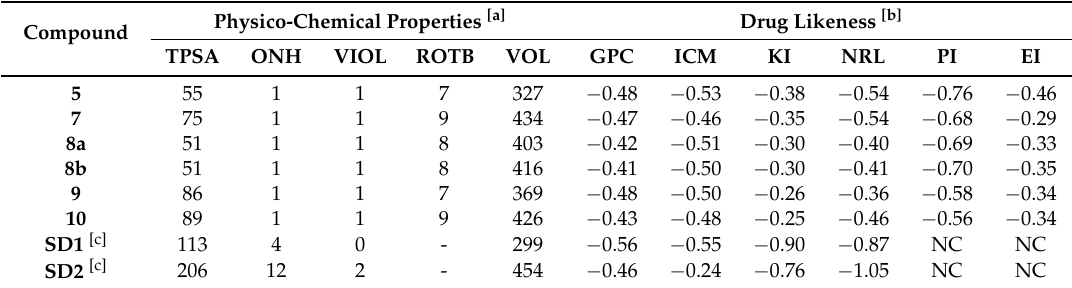
Figure 10. Repartition of partial π -charges of N, O and S atoms of compounds 5 – 10 . The possible antibacterial and antifungal pharmacophores are marked in red and blue color, respectively.